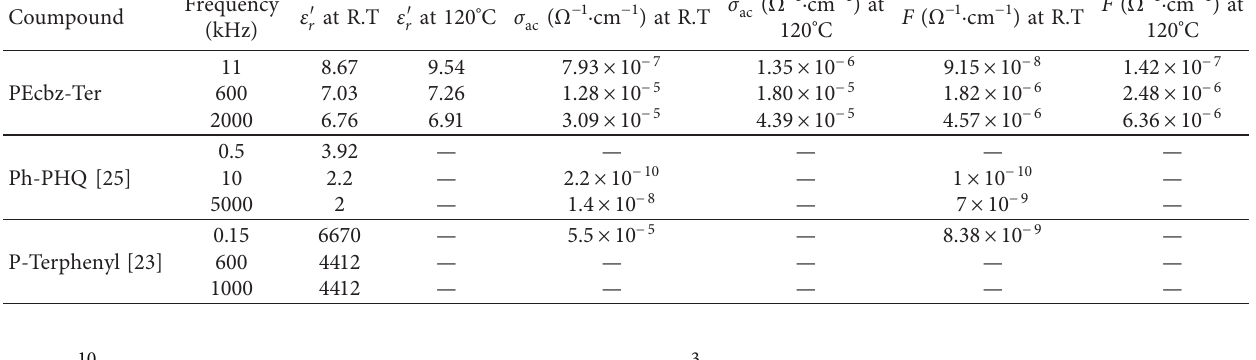
Table 1: Dielectric constant ε r ′ , the conductivity σ ac , and the ratio F at R.T and 120 ° C for PEcbz-Ter, Ph-PHQ, and P-terphenyl. Coumpound